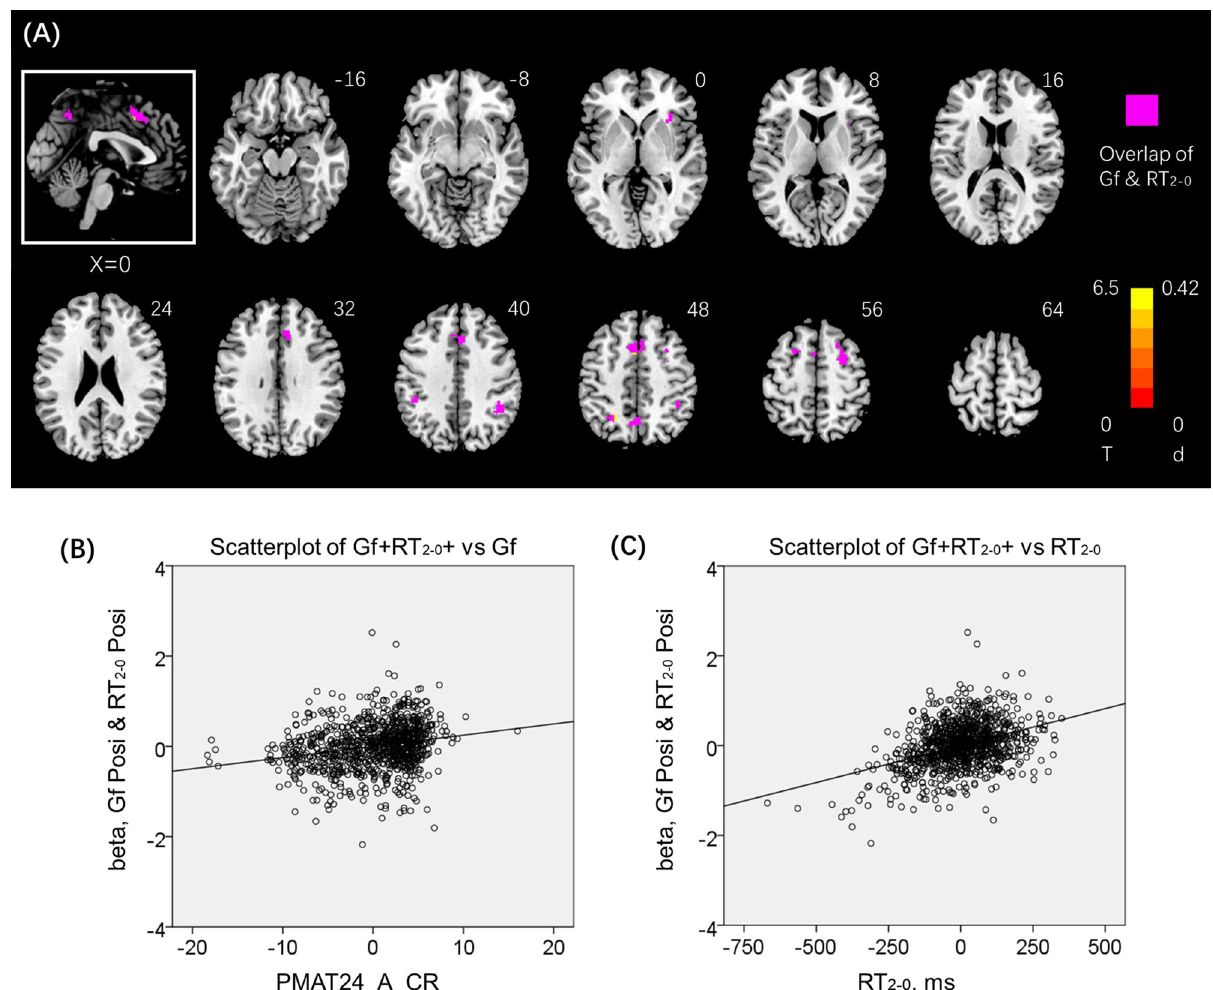
Figure 7. ( A ) Whole-brain multiple regression against PMAT24_A_CR with age, sex, and years of education as covariates. Voxel p < 0.05, FWE corrected. The clusters are summarized in Table 3. Clusters in warm color show higher activation during 2- vs. 0-back blocks in positive correlation with PMAT24_A_CR. Color bars show voxel T values and the corresponding Cohen’s d scores. The inset shows a mid-sagittal section of the clusters. The voxels (almost all) with activation in positive correlation with both Gf and RT 2–0 are highlighted in magenta. Linear regression of ( B ) beta estimates of the magenta clusters (Gf + RT +) vs. Gf (PMAT24_A_CR): Gf + RT + vs. Gf; and (C) Gf + RT + vs. RT 2–0 . Note that the scatter plots show the residuals, after age, sex, and years of education were accounted for. B and C were generated by SPSS Statistics 22.0 (https:// www. ibm. com/ suppo rt/ pages/ spss- stati stics- 220- avail able- downl oad).